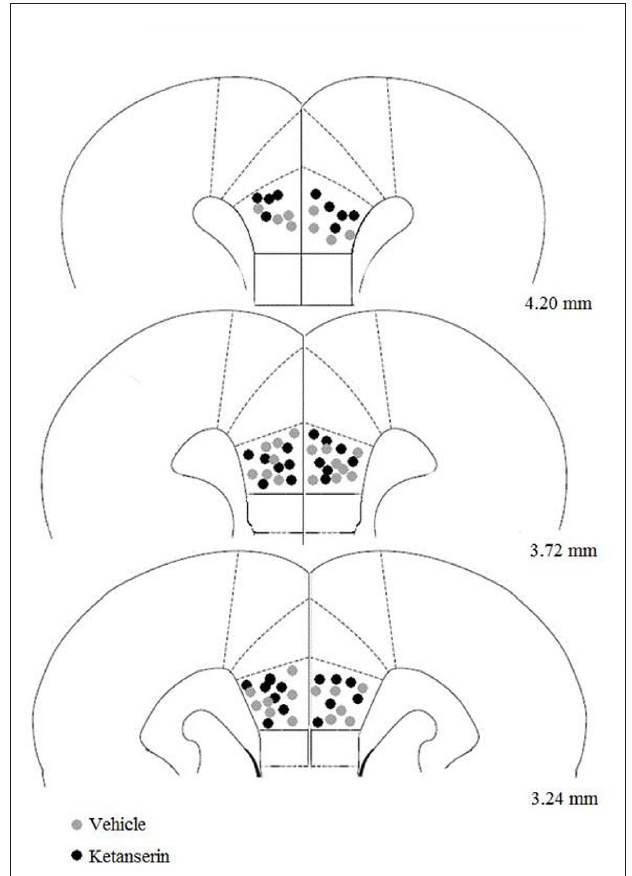
FIGURE 5 | Site of microinjection tips in the prelimbic (PL) cortex. Gray square indicates site of vehicle injection. Black circle indicates site of ketanserin injections. Plates are taken from Paxinos and Watson (1986) and the numbers on the right side of each plate indicate the distance (in millimeters) from